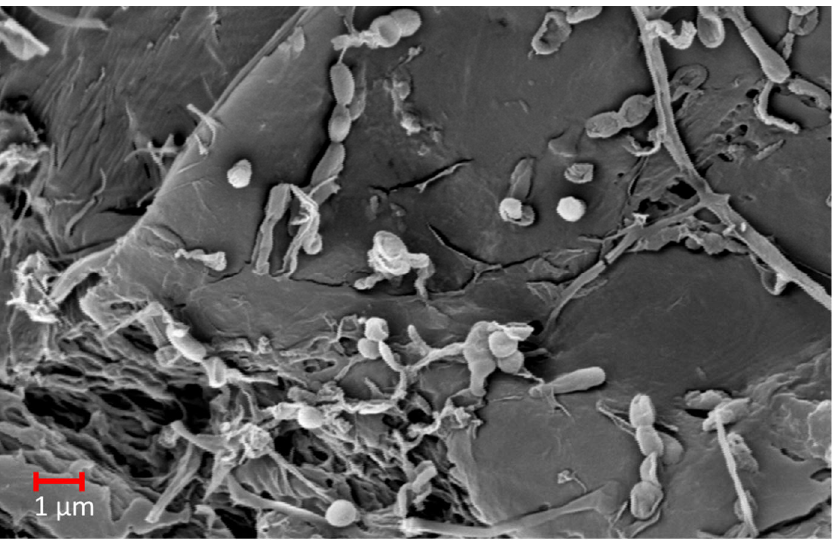
Figure 2. Scanning electron microscopical (SEM) image. The surface of parchment from the Archi ‐ medes Palimpsest [18]. The image was obtained in high vacuum mode using an EVO50 SEM (CarlZeiss) on a gold ‐ metalized sample without further preparation. Picture shows the surface of collagen fibers of parchment at a magnification of about 20,000 X (20KX). Picture and legend: Dr. Flavia Pinzari.